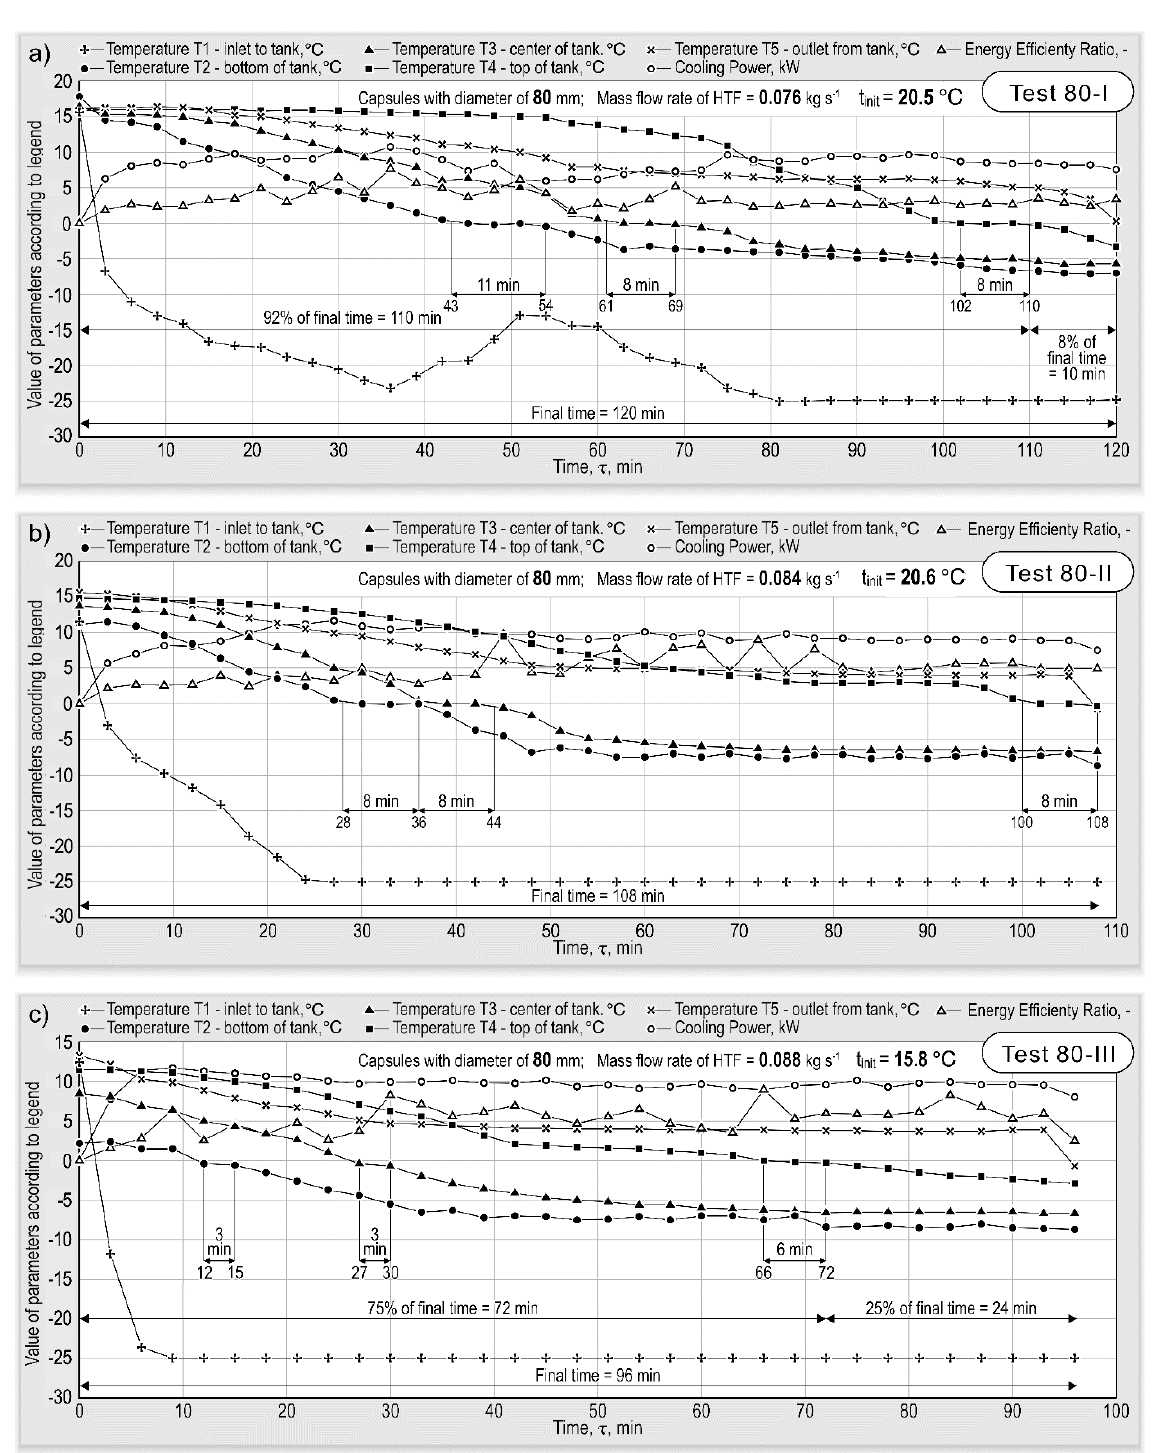
Figure 4. Measurement results: distribution of temperatures, cooling power, and energy efficiency ratio as a function of time for 80-mm-diameter capsules: ( a ) Test 80-I; ( b ) Test 80-II; ( c ) Test 80-III.